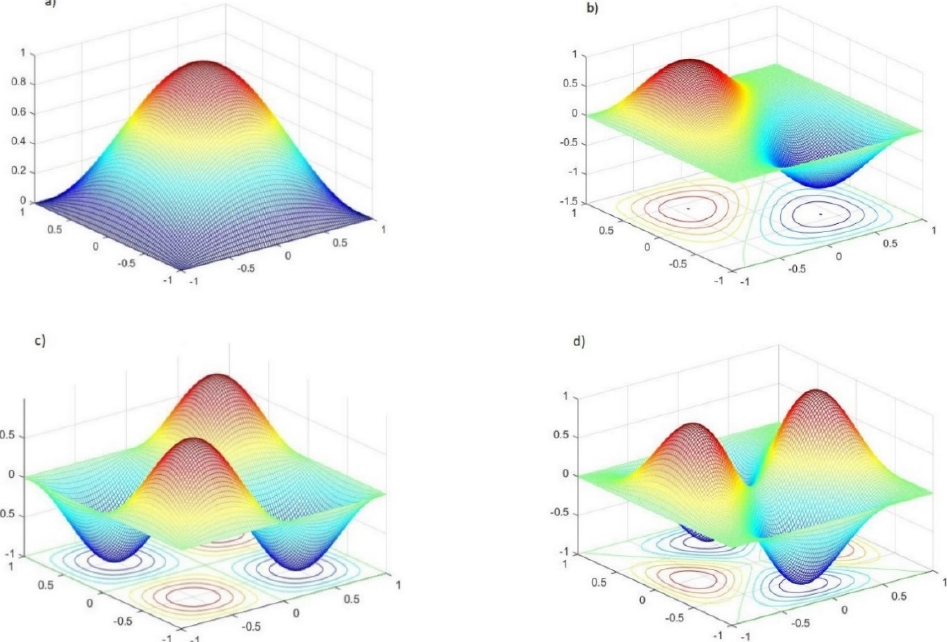
Figure 12. Vibrational modes for the SFG distribution with η = 1 and µ = 0.75: ( a ) 1st mode, ( b ) 2nd mode, ( c ) 4th mode, ( d ) 5th mode.